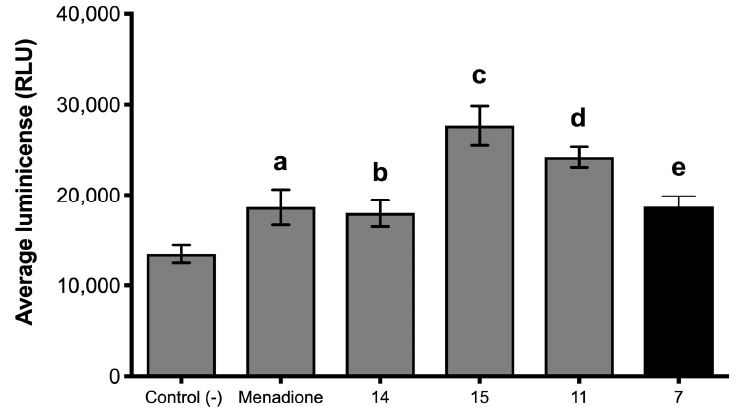
Figure 7. Effect of compounds 7 , 11 , 14 and 15 on production of reactive oxygen species by Botrytis cinerea . Compounds concentrations were equal to their IC 50 values, whereas menadione used as positive control was applied at 10 ppm final concentration (a, and b indicate statistical differences with respect to the negative control).